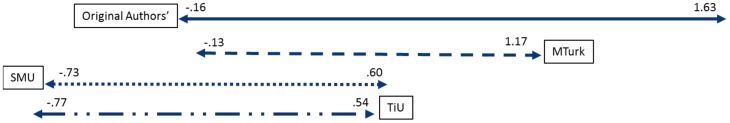
Those asked to write about a belongingness threat should report greater loneliness levels, as compared to those who wrote about things in their apartment.